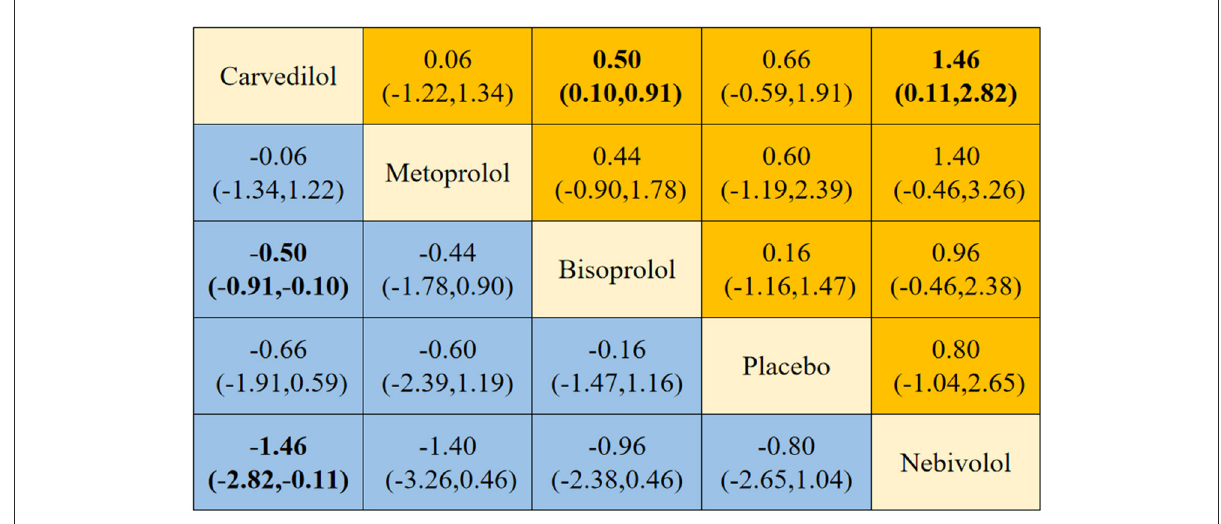
FIGURE8 Results of network meta-analysis.